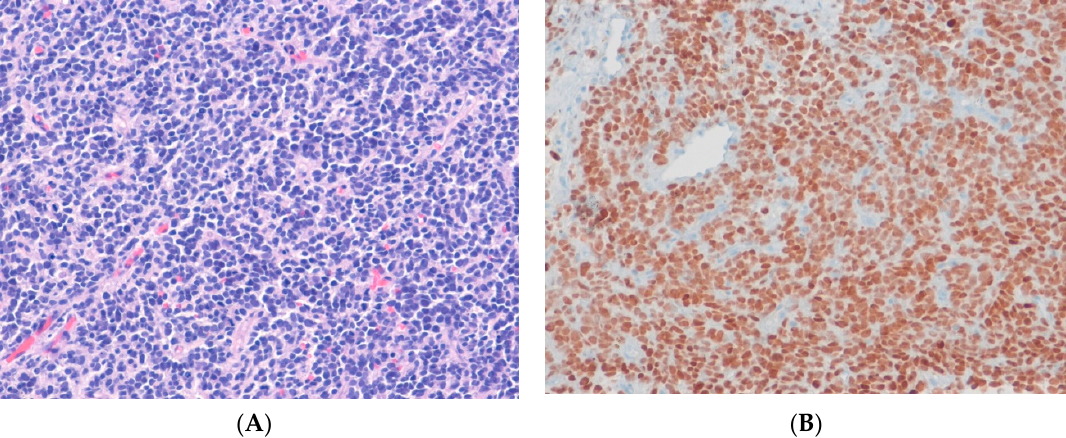
Figure 9. BCOR -rearranged sarcoma. ( A ) The tumor shows solid sheets of monomorphic round cells with round nuclei and scant eosinophilic cytoplasm, with delicate capillaries (H&E stain, ×100). ( B ) The tumor cells show di ff use nuclear staining for BCOR, indicating the presence of an underlying